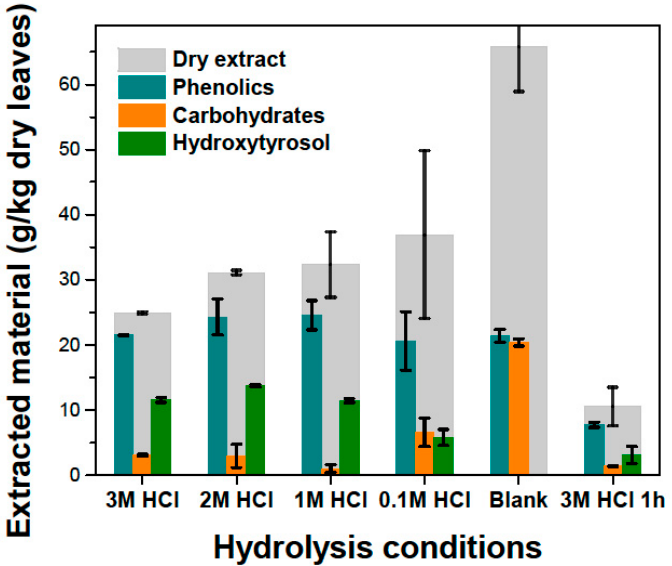
Figure 7. Effect of HCl concentration on the substance profile of the final extract. Blank experiment was performed without any added acid. The experiment with 3 M HCl was also performed for 1 h to examine the effect of hydrolysis conditions on the phenolic profile and mainly hydroxytyrosol.